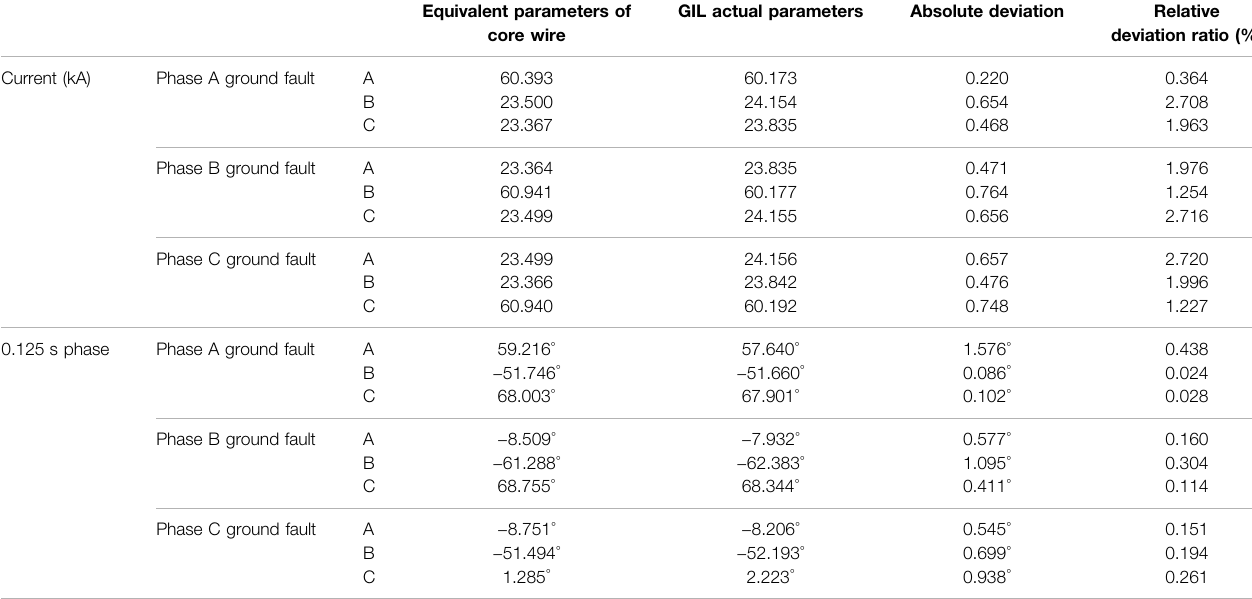
TABLE 5 | Comparison table of the three-phase currents on the N side between the equivalent parameter model of the core wire and actual GIL parameter model in case of grounding faults.